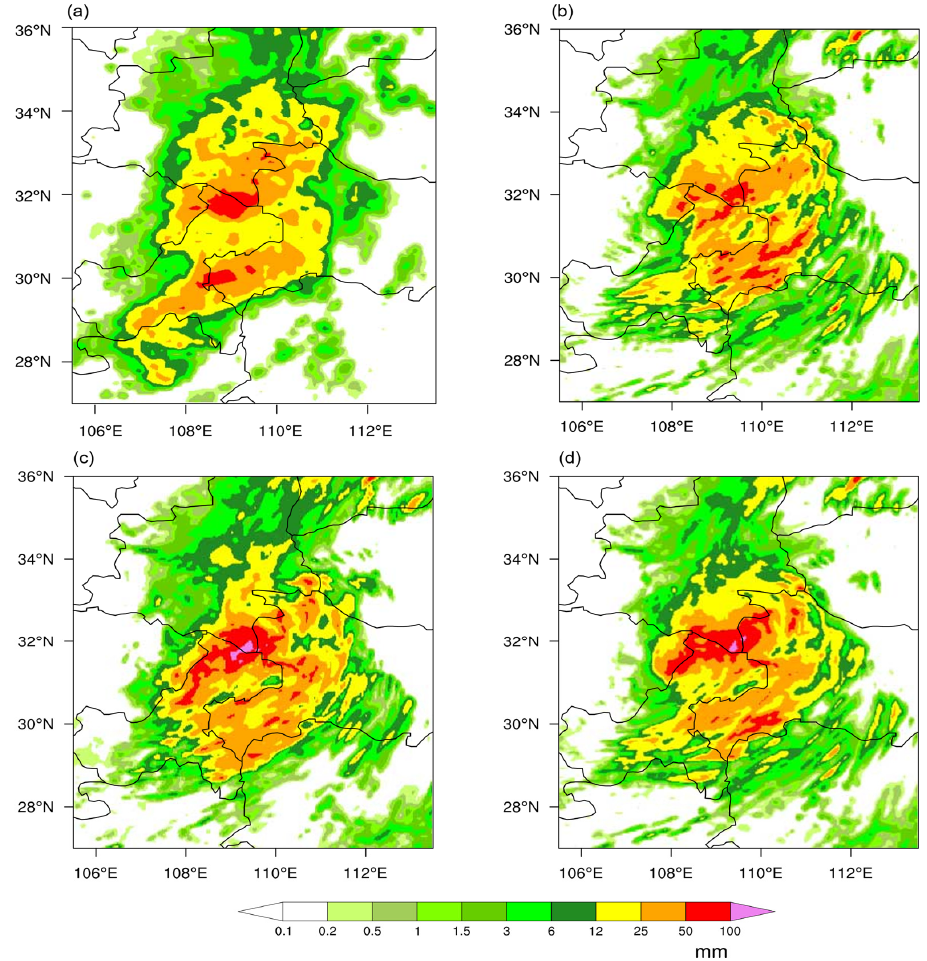
Figure 13. 6 h cumulative precipitation (shaded; units: mm). ( a ) Observation, ( b ) CTRL, ( c ) ψ−χ control variable, ( d ) U − V control variable.